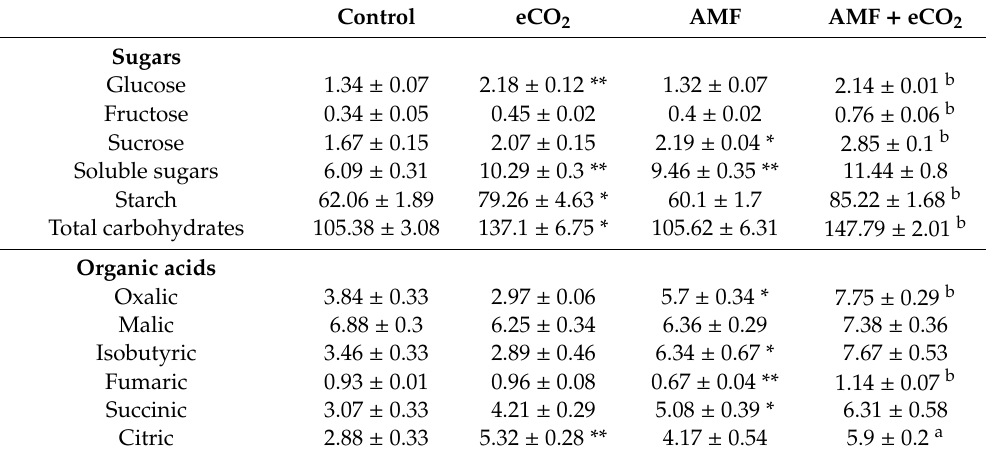
Table 2. Levels of primary metabolites (mg g − 1 dry weight) in Thymus vulgare grown under normal conditions (control) or the e ff ect of eCO 2 (620 ppm), AMF or their combination (AMF-eCO 2 ). Values are mean ± standard error of five independent replicates. Asterisks indicate significant changes (* p < 0.05; ** p < 0.01) compared to control, as revealed by the Student’s t-test. Lowercase letters indicate significant di ff erences ( a p < 0.05; b p < 0.01) between AMF alone and the combined AMF + eCO 2